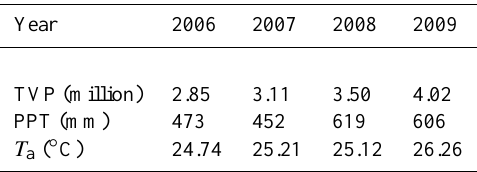
Table 2. Total vehicle population (TVP), annual precipitation (PPT), and annual average air temperature ( T a ) from 2006 to 2009. TVP data were derived from Wu et al. (2011). PPT and T a data were collected from Caoyang weather